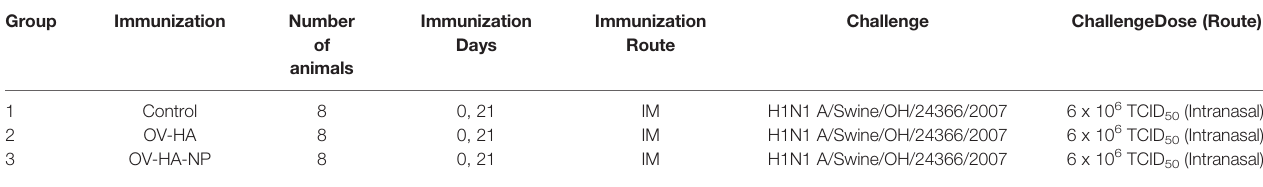
TABLE 1 | Experimental design for immunization-challenge